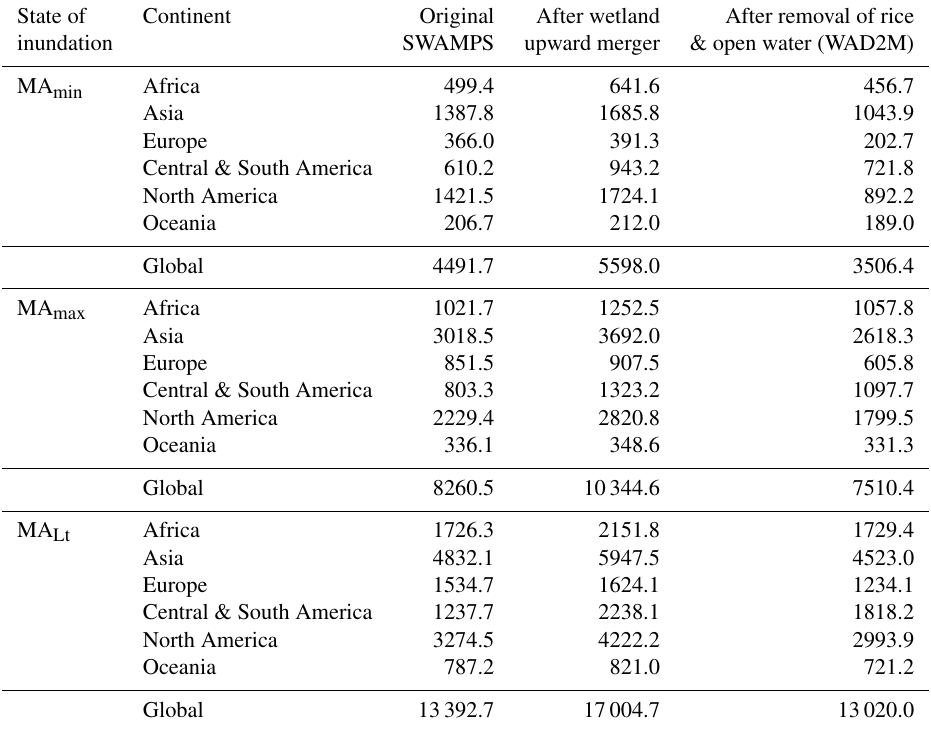
Table 1. Three states of inundation (unit 10 3 km 2 ) at different steps of the processing of WAD2M. State